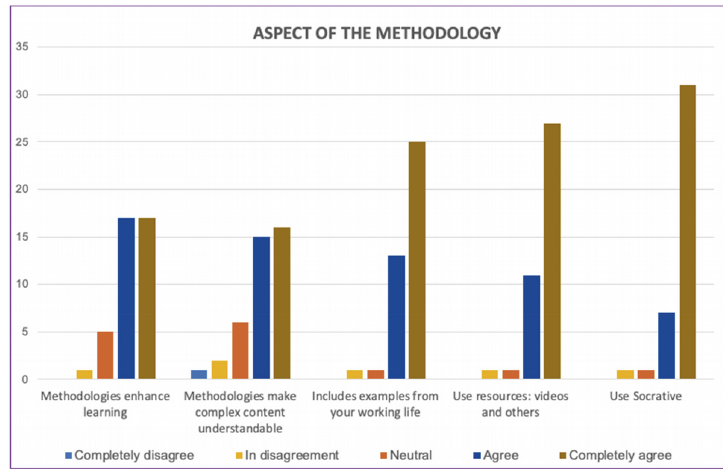
Figure 6. Degree of agreement or disagreement regarding methodology